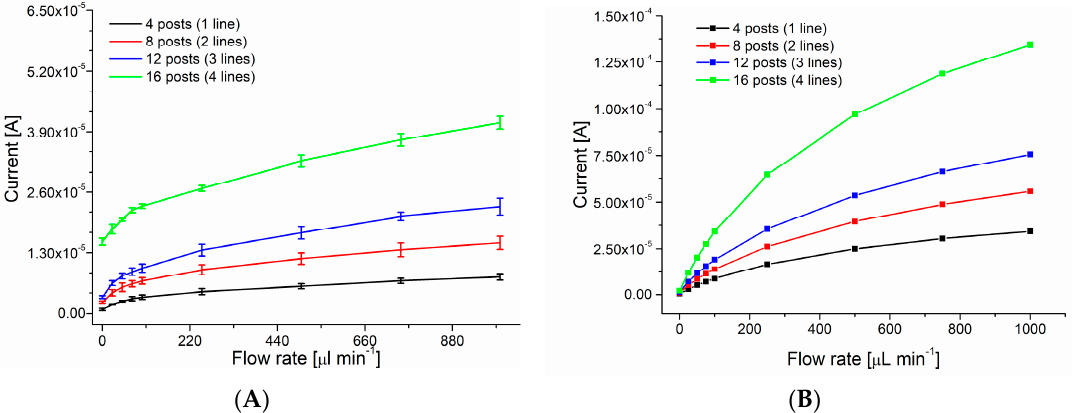
Figure 4. Limiting current registered for 3D working electrodes formed from four to 16 graphite posts (four posts/one line –black, eight posts/two lines –red, 12 posts/three lines –blue, 16 posts/four lines –green). Chronoamperometry performed at 0.35 V vs. Ag/AgCl. ( A ) Experimental data, standard deviation calculated for n = 3 devices, ( B ) Calculated data.